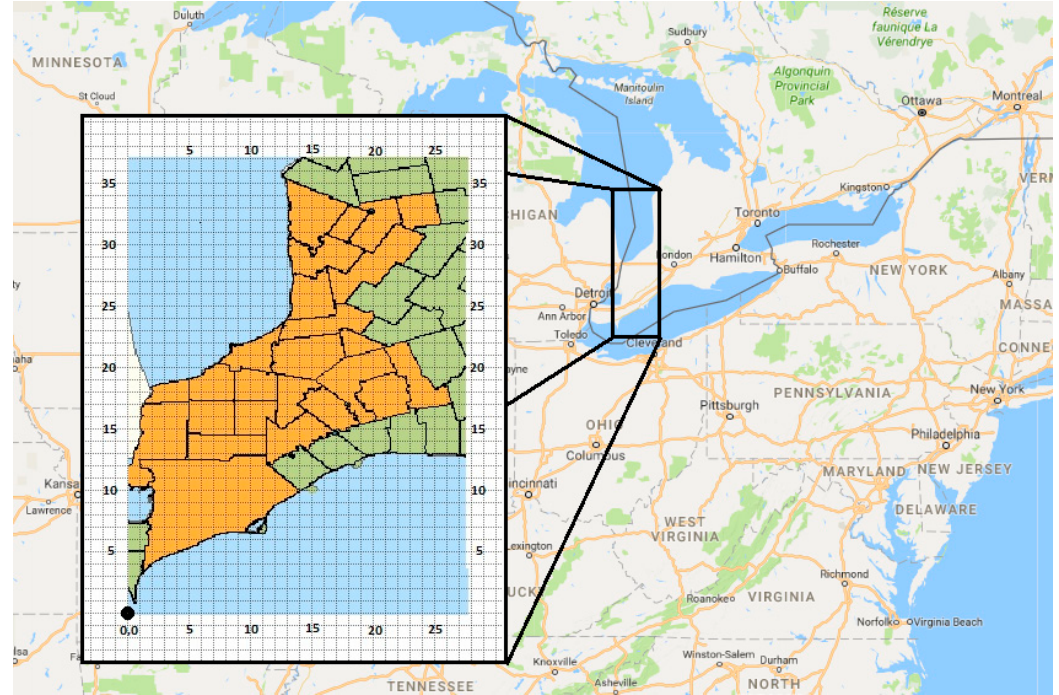
Figure 4. Geographical location (based on [44]).